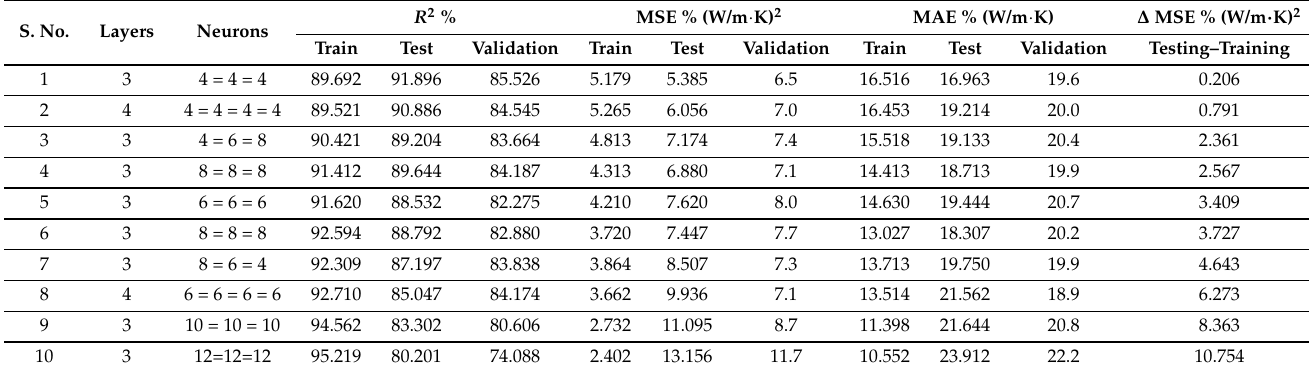
Table 2. Training, testing and validation results considering Network - II .